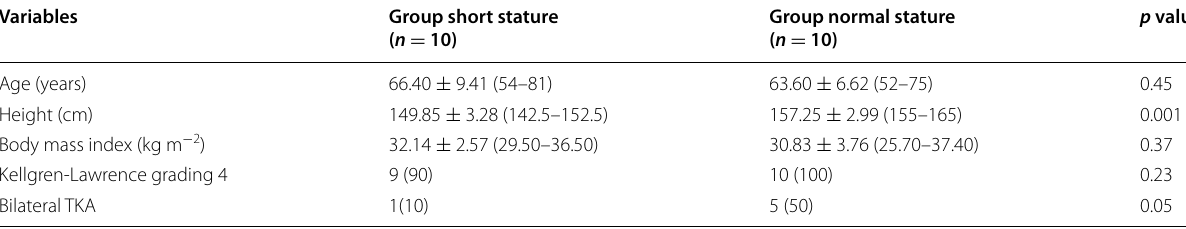
SD (range) or number (%) ±